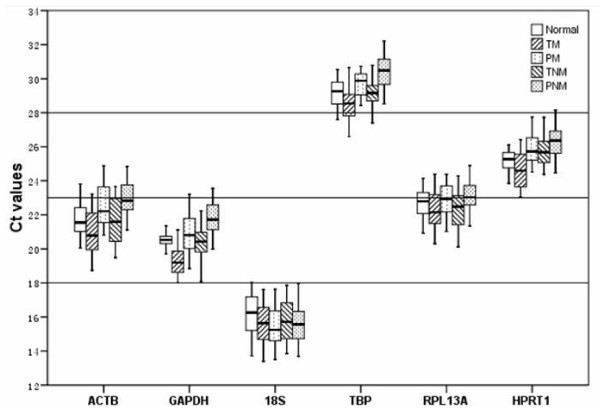
Expression level of candidate reference genes. We observed the six housekeeping genes in normal liver specimens(Normal), paired tumor and non-tumor liver specimens of HCCs with-metastasis (TM and PM), paired tumor and non-tumor liver specimens of HCCs without-metastasis (TNM and PNM). Values are given as real-time PCR cycle threshold numbers (Ct values). Boxes represent the lower and upper quartiles with medians. The arbitrary lines at Ct 18, 23 and 28 distinguish the groups of differently expressed housekeeping genes.